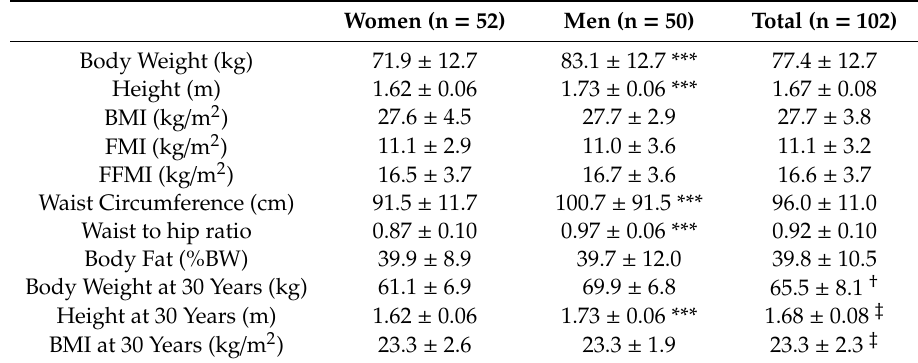
Table 1. Anthropometric characteristics of the sample (mean ± SD).